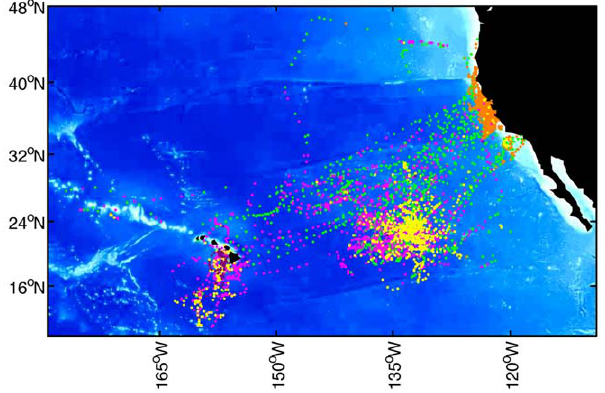
Figure 2. Daily median white shark position estimates from 53 tracks, Each position estimate is colored according to behav- ioral cluster; cluster 1 (yellow; ‘ROD’), cluster 2 (purple; ‘Cluster 2’), cluster 3 (green; ‘Travel’), cluster 4 (magenta; ‘DVM’), cluster 5 (orange; ‘Coastal’). The distinct diving behaviors, distinguished by each cluster, generally differed in the locations where they most commonly occurred. The ‘Coastal’ behavior occurred primarily along the North American coast, ‘ROD’ primarily at the ‘white shark Cafe´’, while ‘DVM’ occurred throughout the offshore area (the Cafe´, Hawaii, and in between) and ‘Travel’ connected North America and the offshore core areas (the Cafe´ and Hawaii).